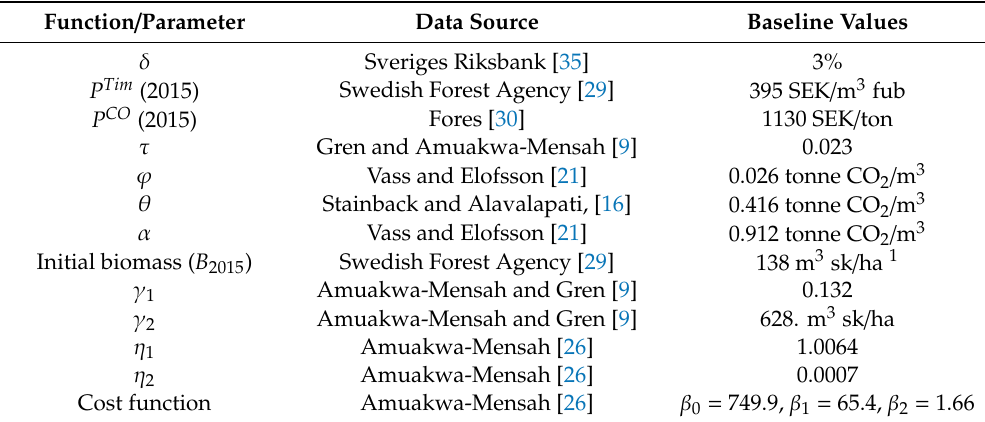
Table 1. Functions, parameter values and data